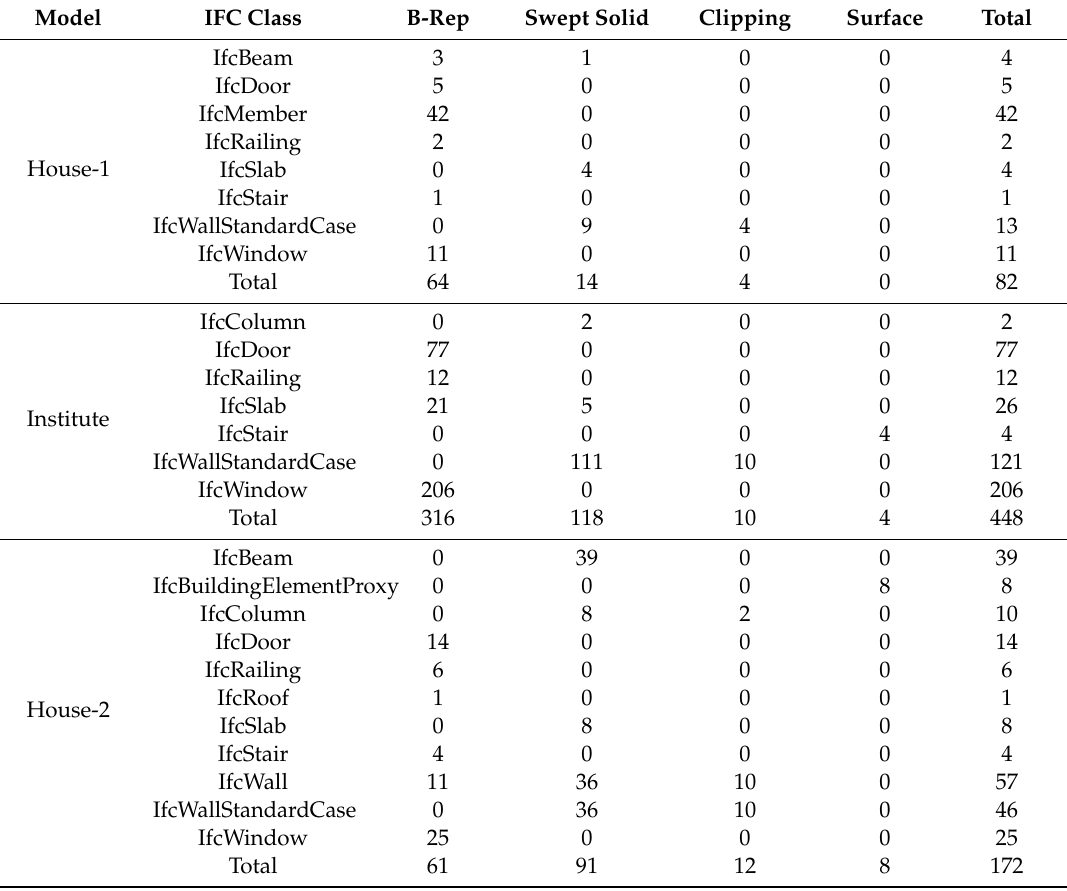
Table 6. Quantity of entities for each building element that are represented by B-Rep, swept solid, clipping, and